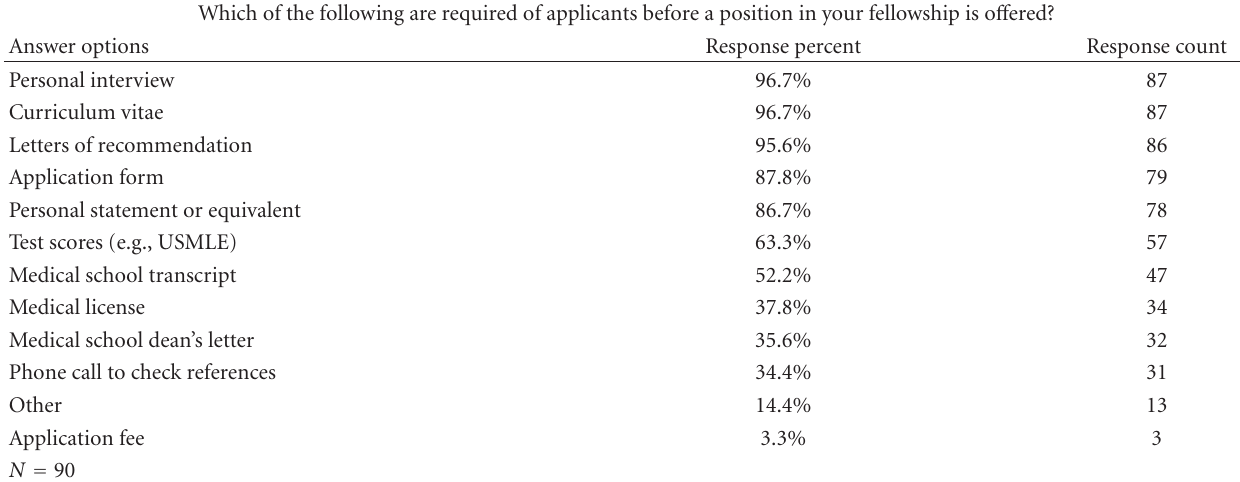
Table 1: Program directors’ responses about application